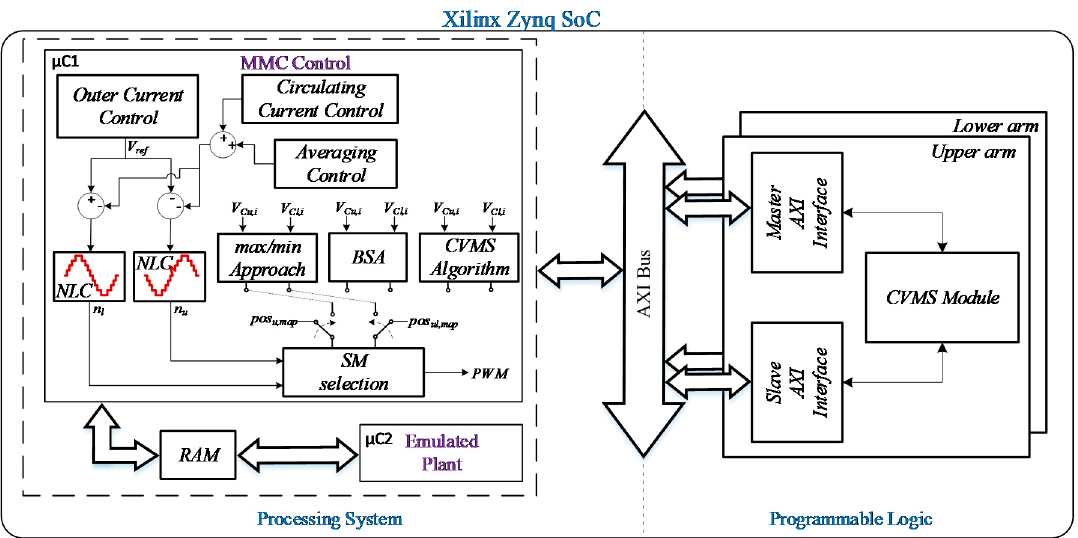
Figure 10. Hardware architecture of the developed system.